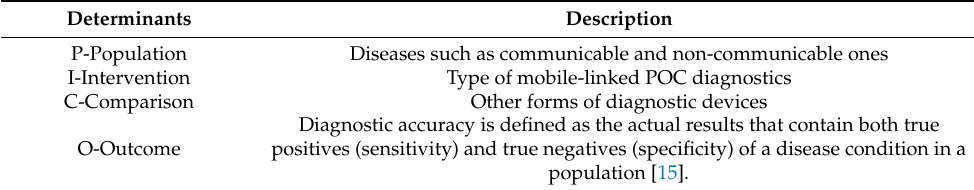
Table 1. PICO framework for determining the eligibility of the research